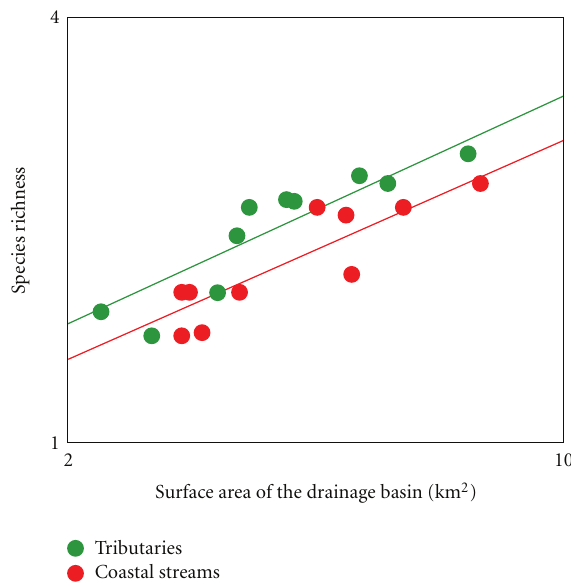
Figure 6: Relationship between species richness and total surface area of the drainage basin for tributaries and coastal rivers of North- Western France: redrawn from Belkessam et al.